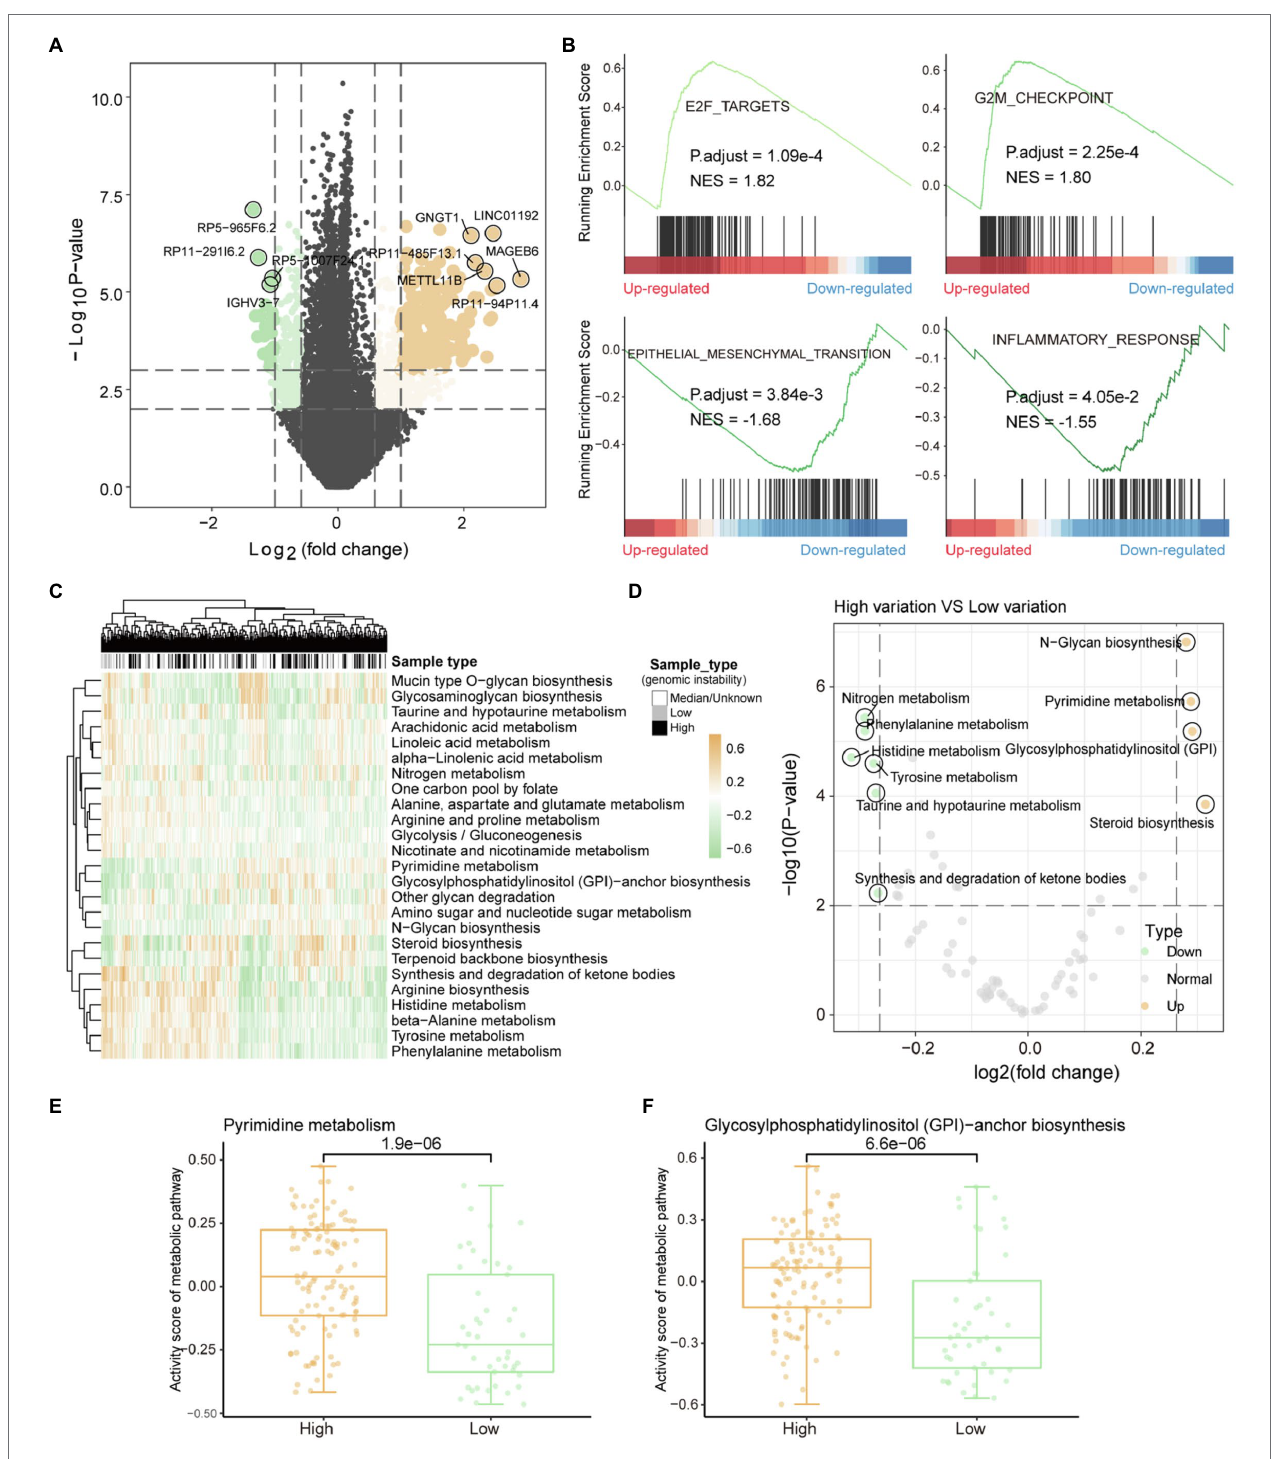
FIGURE 2 | Metabolic remodeling based on genome instability. (A) The results of the differential gene expression analysis between high-genomic instability and low-genomic instability samples are shown by the volcano graph. Grey dots represent non-differentially expressed genes, yellow dots indicate genes upregulated in high-genomic instability samples, and the green dots mean the opposite. (B) gene set enrichment analysis results of differentially expressed genes. Normalized enrichment score and corrected value of p are calculated. (C) The enrichment scores of tumor samples in each metabolic pathway calculated by GSVA are displayed by heat map. Column labels show sample types, including high-/low-genomic instability and median. (D) Analysis of the difference of metabolic pathway activity scores between high-genomic instability and low-genomic instability samples. (E,F) Comparison of pyrimidine synthesis and glycosylphosphatidylinositol- anchor biosynthesis pathway activity among high-/low-genomic instability samples. The rank sum test is used to calculate the